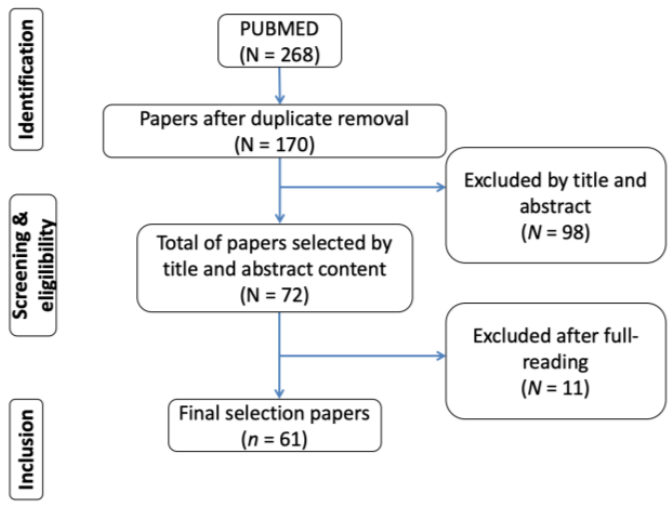
Figure 1. Schematics on the search and selection of articles.